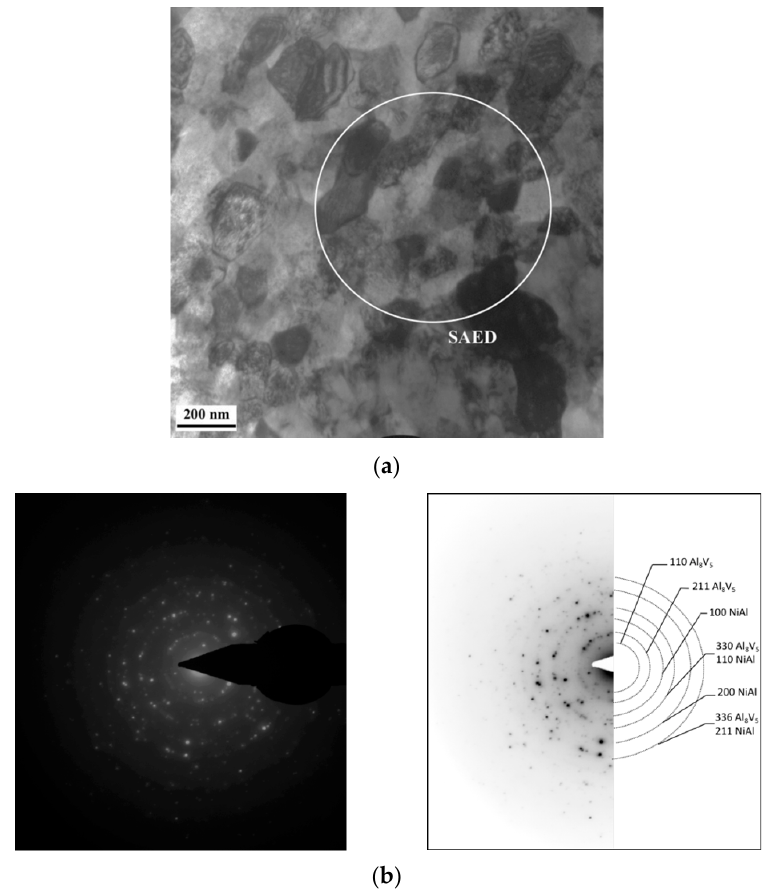
Figure 6. ( a ) Transmission electron microscopy (TEM) image of the grains that composed the center of the TiNi/Ti6Al4V interface and ( b ) Selected area electron diffraction (SAED) of the selected area indicated in ( a ) and the indexing scheme of the diffraction pattern.